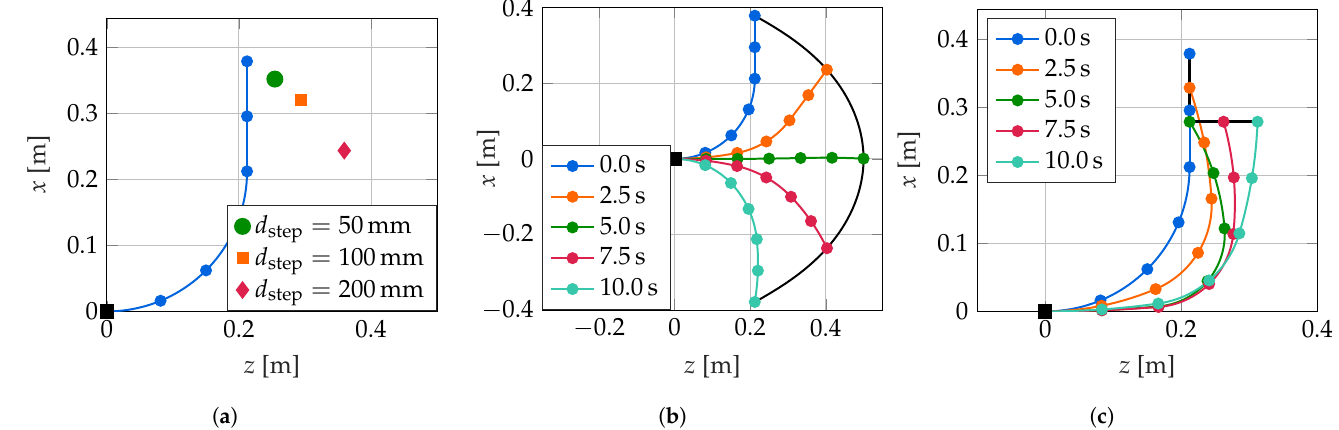
Figure 10. Examined trajectories. ( a ) Step trajectory. ( b ) Swing trajectory. ( c ) L-shape